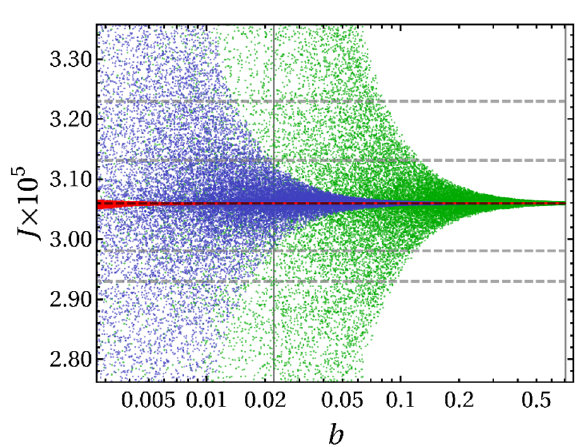
Figure 6 . Scatter plot of J 2233 (green), J 1223 (blue) and ( (cid:0) J 1132 ) (red) as a function of b for M B = 1 : 3 TeV. The dashed lines mark the 1 (cid:27) and 2 (cid:27) intervals of CKM(cid:12)tter [68, 69]. They enclose the black dashed line representing J of the SM at the best-(cid:12)t. The vertical gray lines show the interval in (7.21). The parameters (cid:12) 2 ; (cid:12) 3 ; (cid:13) are varied through their whole